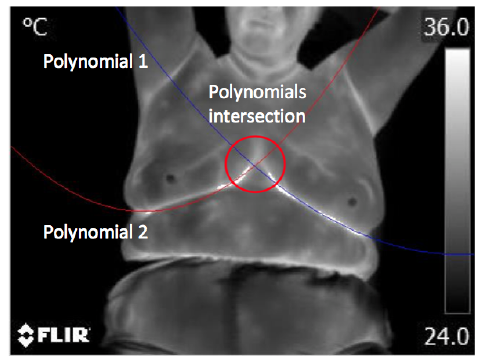
Figure 10. Polynomials to fully find inferior limits of breast area and its intersection.